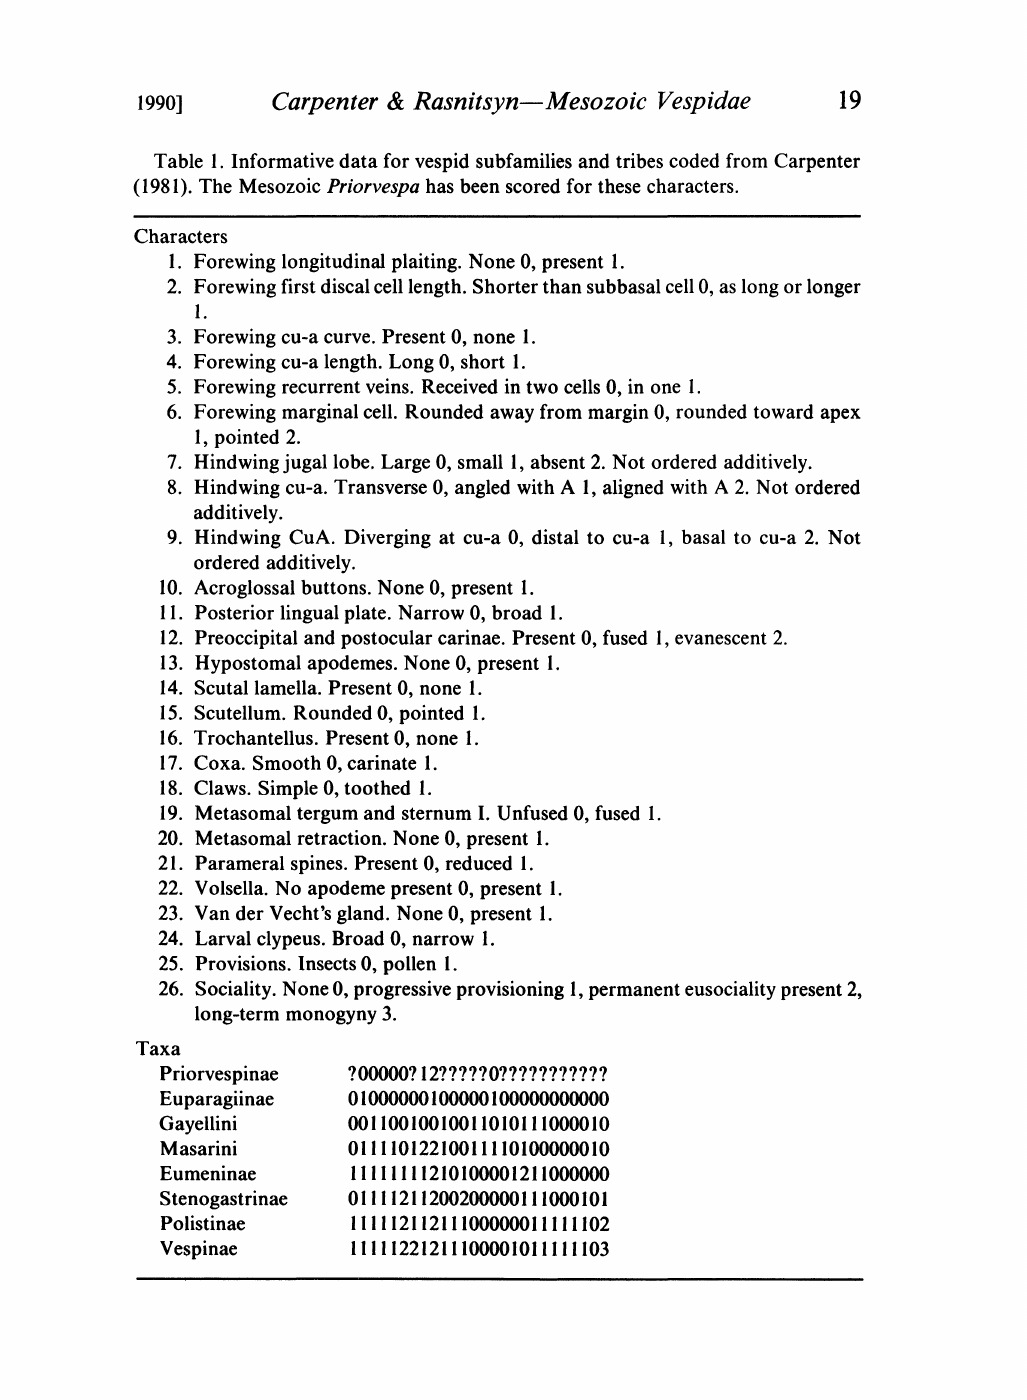
Table 1. Informative data for vespid subfamilies and tribes coded from Carpenter (1981). The Mesozoic Priorvespa has been scored for these characters.